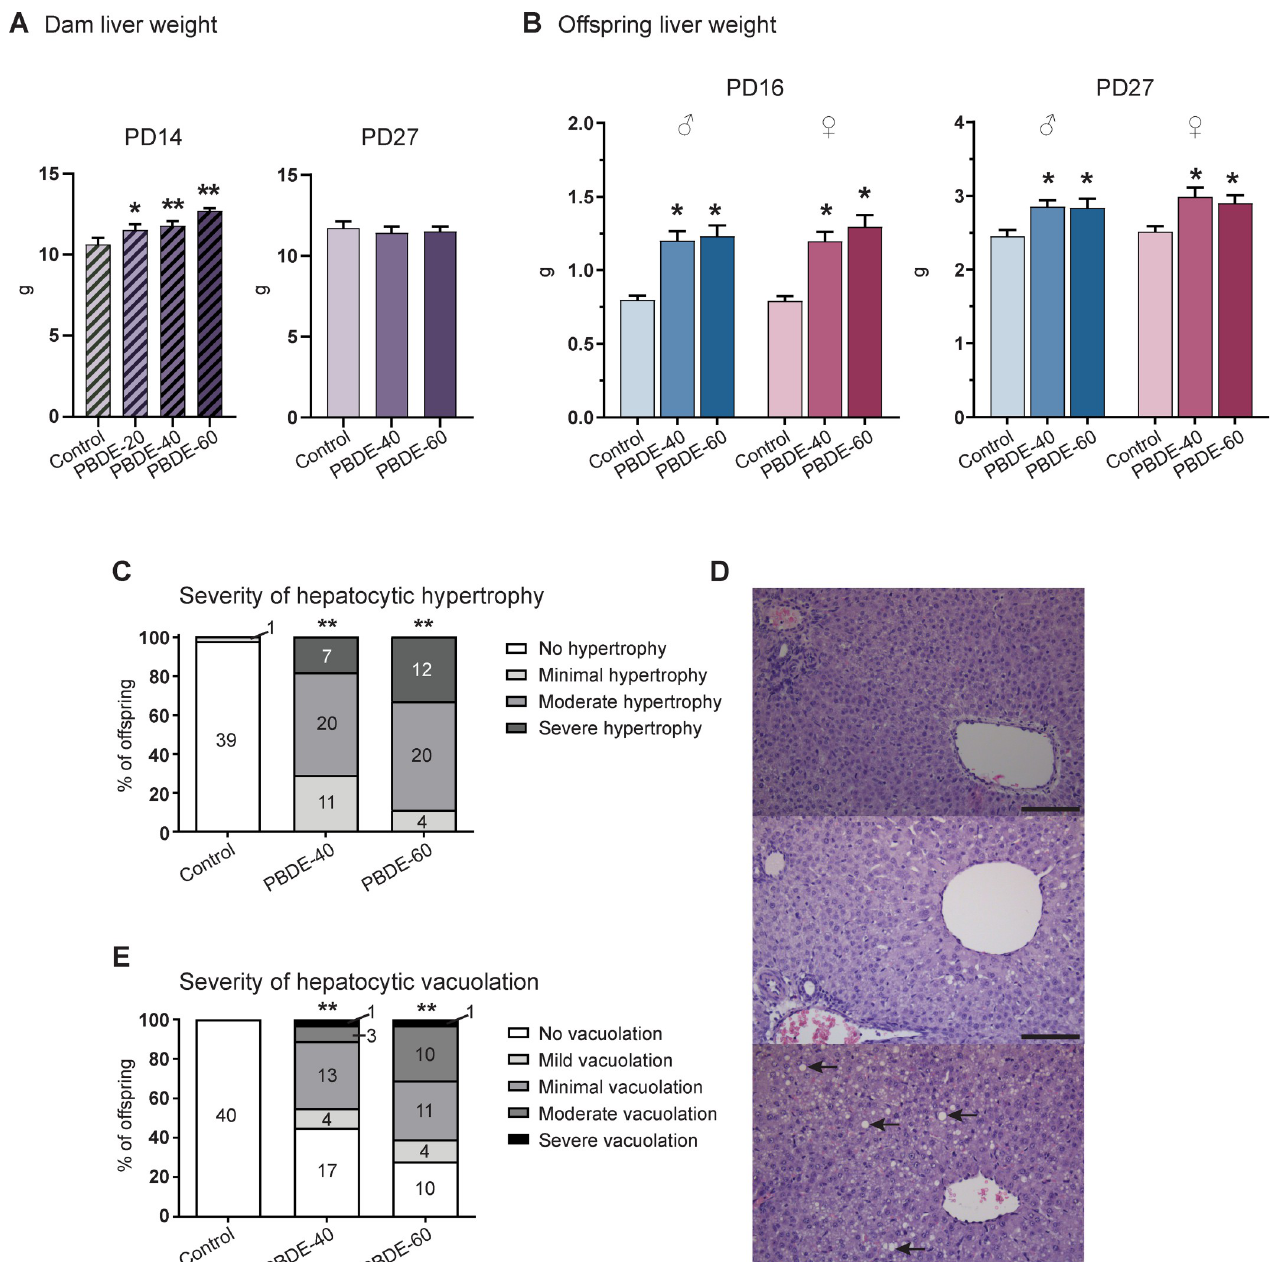
Fig 4. Effects of DE-71 exposure from GD7-PD14/16 on dam and pup liver weights and histology. (A) Dam liver weights were increased dose-dependently in Study 1 on PD14, while there were no effects on PD27 in Study 2. n = 7 in Study 1, n = 19–21 in Study 2. Mean + SEM. (B) Male and female pup liver weights PD16 and PD27. n = 17–21. Mean + SEM. (C) Severity of hepatocytic hypertrophy in male and female offspring PD16. Centrilobular hypertrophy was observed in all exposed animals. Number of assessed offspring shown in each bar. n = 36–40. (D) Male PD16 liver from control (top), high-dose presenting with severe centrilobular hepatocytic hypertrophy (middle) and high dose with moderate hepatocytic vacuolation (bottom). Arrows show examples of large macrovesicular vacuoles in hepatocytes (E) Severity of hepatocytic vacuolation in male and female offspring PD16. Significantly increased incidence of vacuolation was seen in exposed offspring. Number of assessed offspring shown in each bar. n = 36–40. � p < 0.05, �� p < 0.01. Scalebar = 100 μ m. PBDE: polybrominated diphenyl ethers (DE-71), PD: postnatal day.